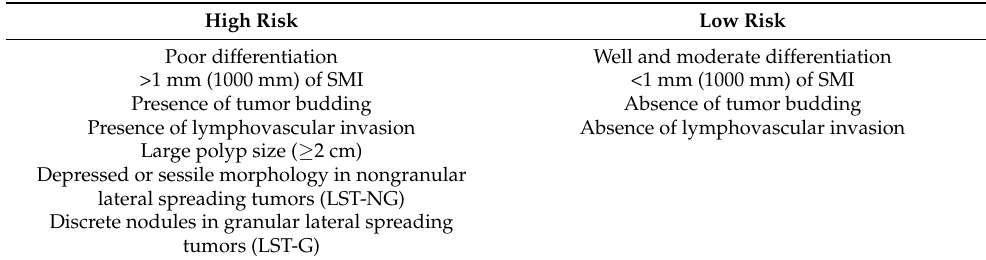
Table 1. Criteria for definition of high-risk and low-risk features for submucosal invasion